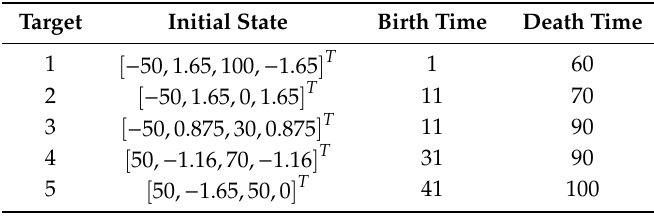
Table 1. Motion parameters of targets